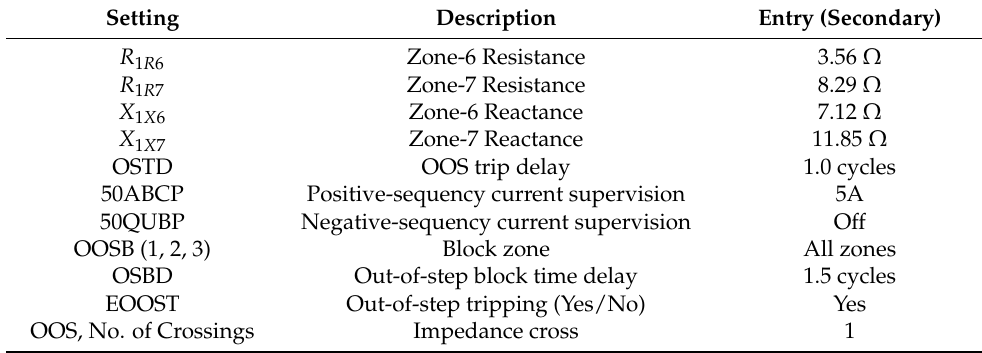
Table 2. Settings of OOS protection SEL421 installed at Test System.